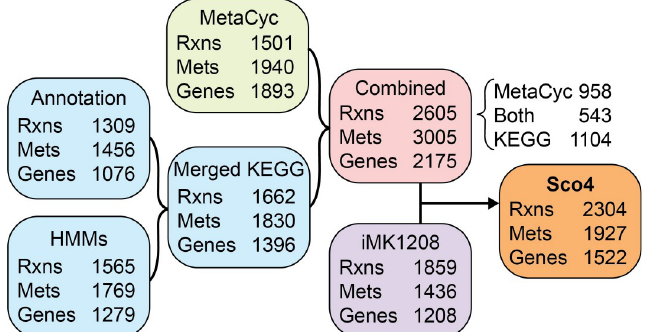
Fig 2. Schematic illustration of Sco4 model generation by RAVEN 2.0. Three draft GEMs were automatically reconstructed in de novo based on MetaCyc and KEGG databases. The two GEMs derived from KEGG genome annotation and HMMs were merged and then subsequently combined with the MetaCyc-based model. The reactions and annotations in the combined draft model were used for manual curation of iMK1208 to result in